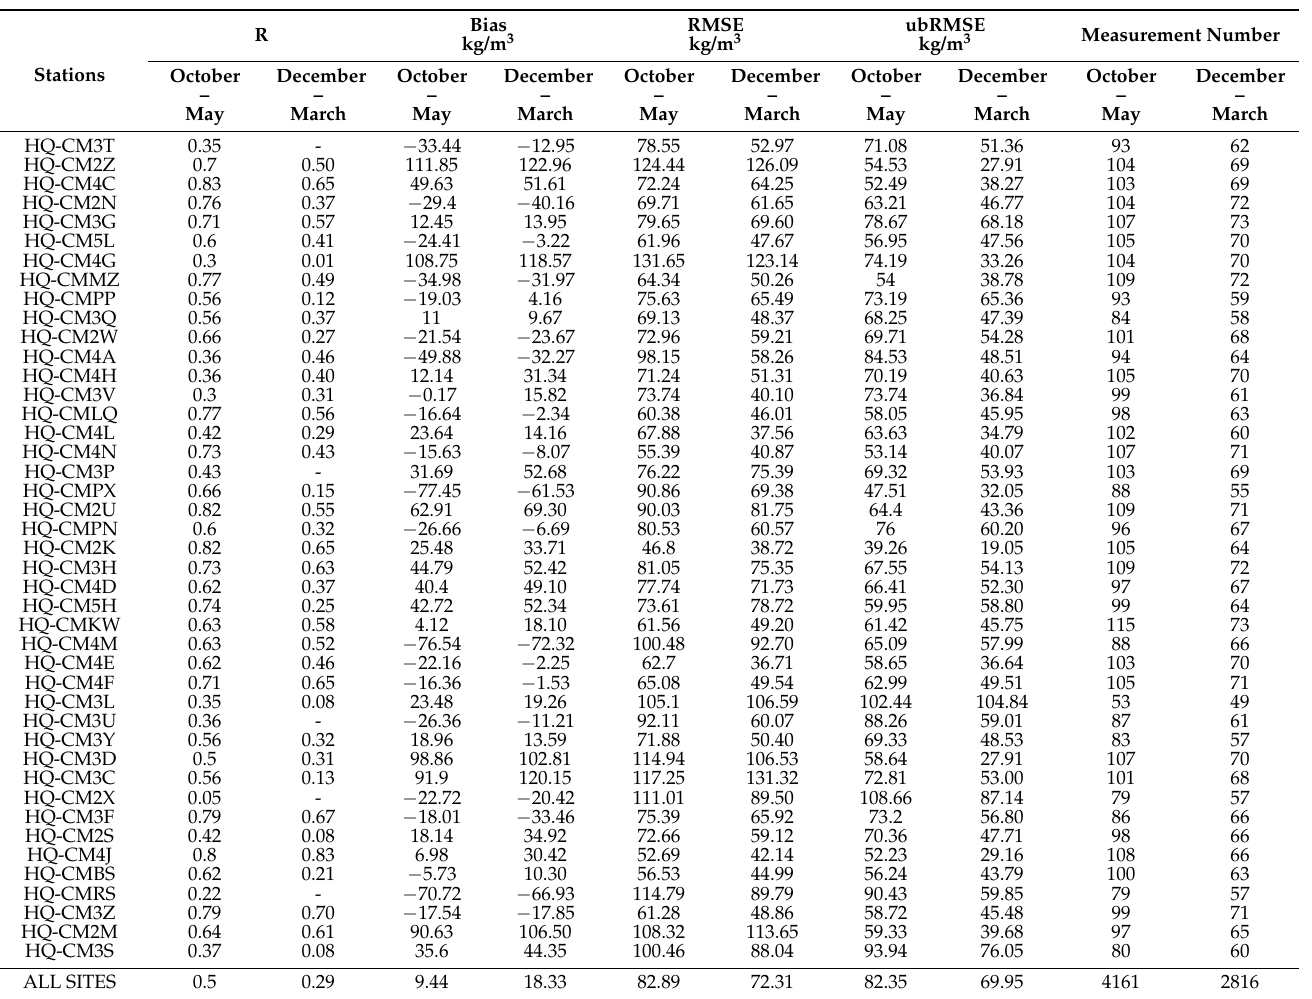
Table A1. The validation metrics of retrieved snow density compared with in-situ measurements at each